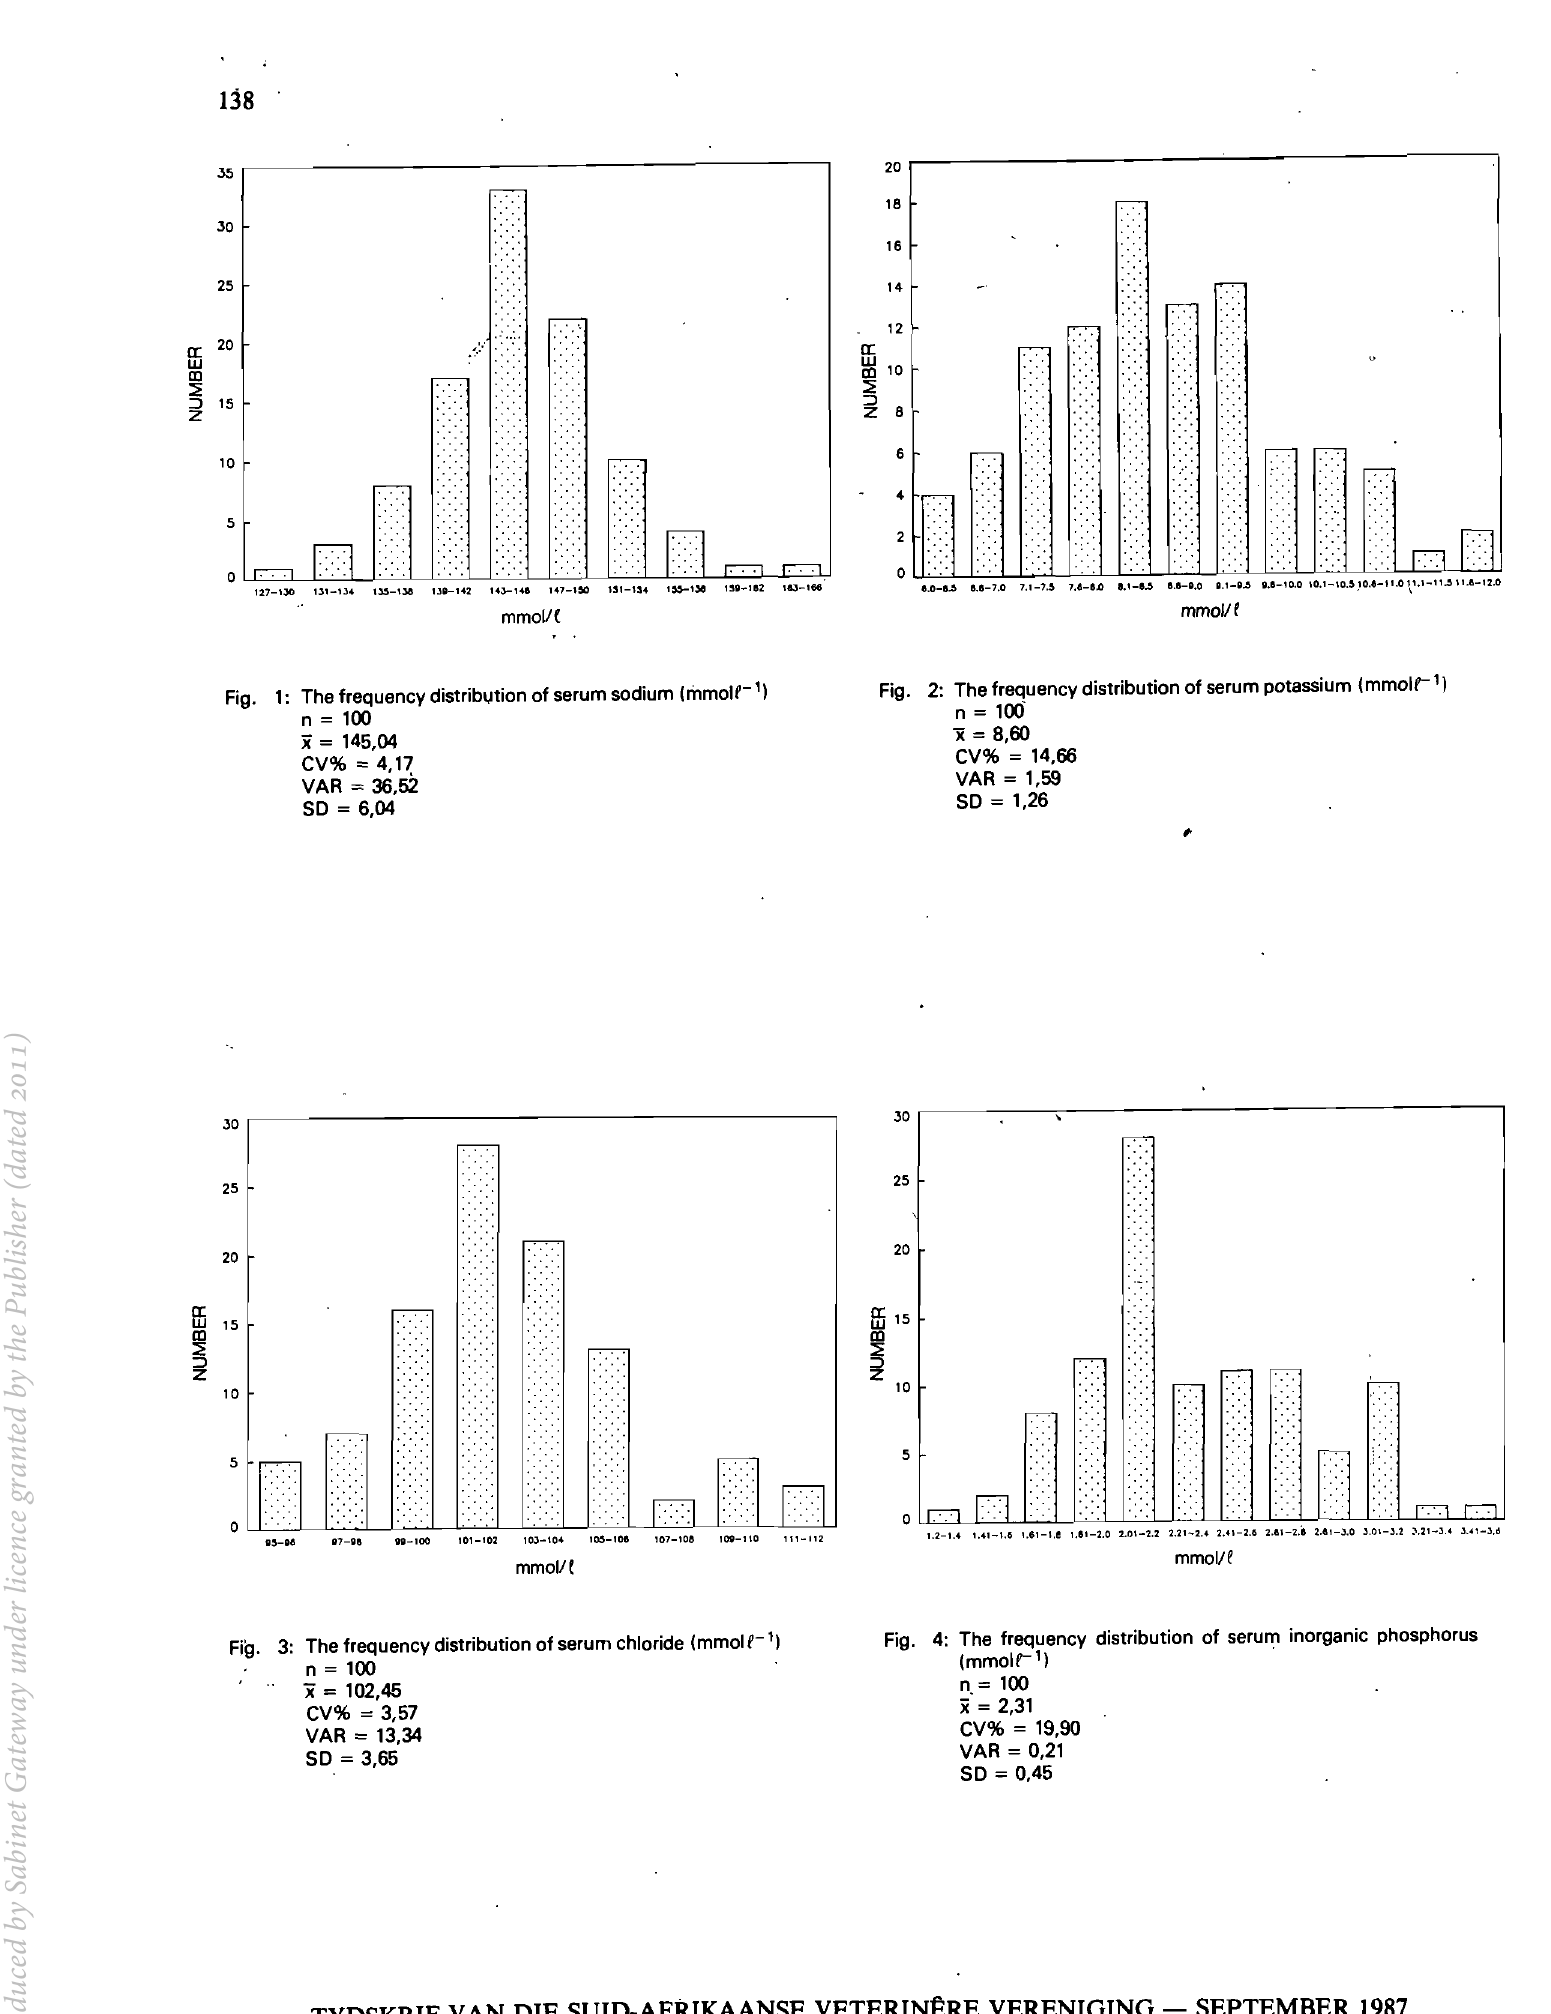
TYDSKRIF VA,N DIE SUID-AFiUKAANSE VETERIN~RE VERENIGING -- SEPTEMBER